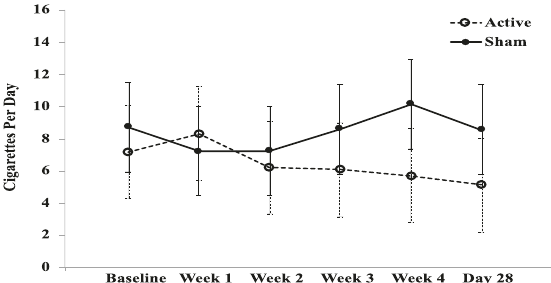
Fig. 4 Interaction plot of cigarette use over time between active and sham treatment. Interaction plot of cigarette use over the course of the trial with values given as estimated marginal means (EMM) ± standard error was used as error bars. EMM were used in interaction plots as a function to visualize the model at the group level (active and sham, each time point), not at the participant or data point level.